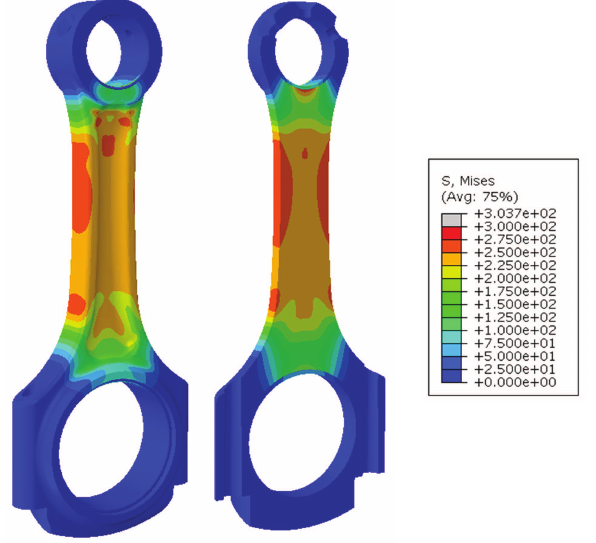
Fig. 7. Results of simulation tests, connecting rod compression 3